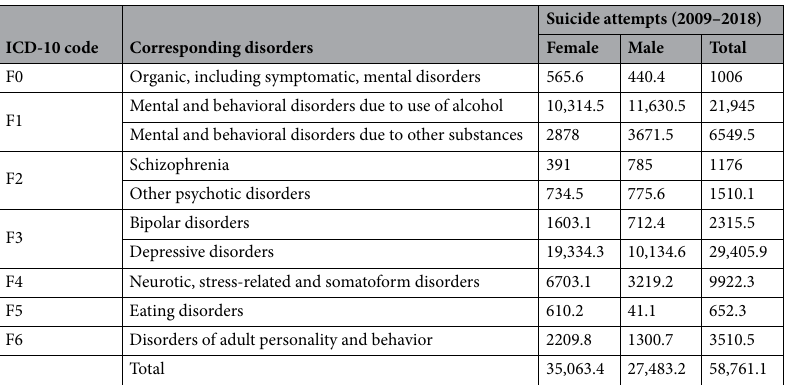
Table 1. Average number of psychiatric disorders associated with suicides and suicide attempts per year. ICD- 10 International Classification of Diseases, 10th